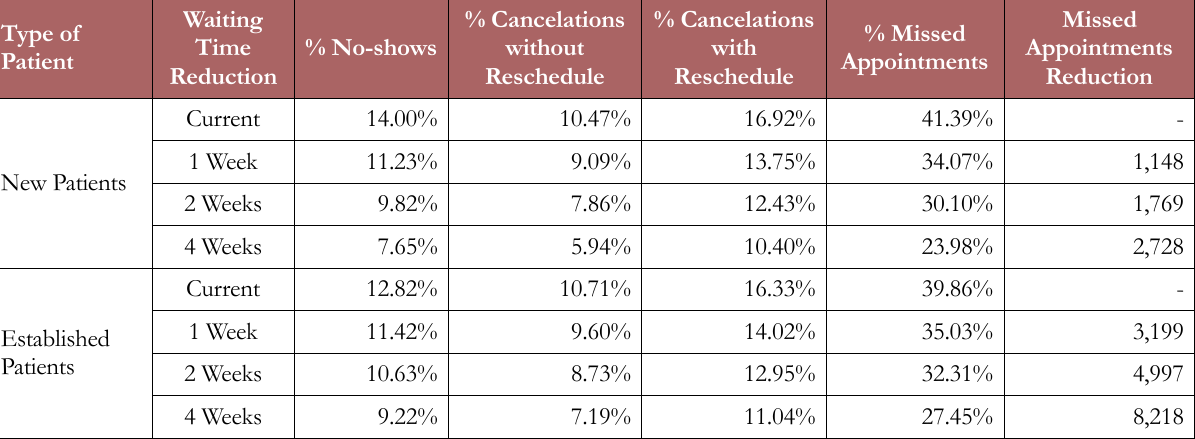
Table 3. Waiting time reduction impact on missed appointments –